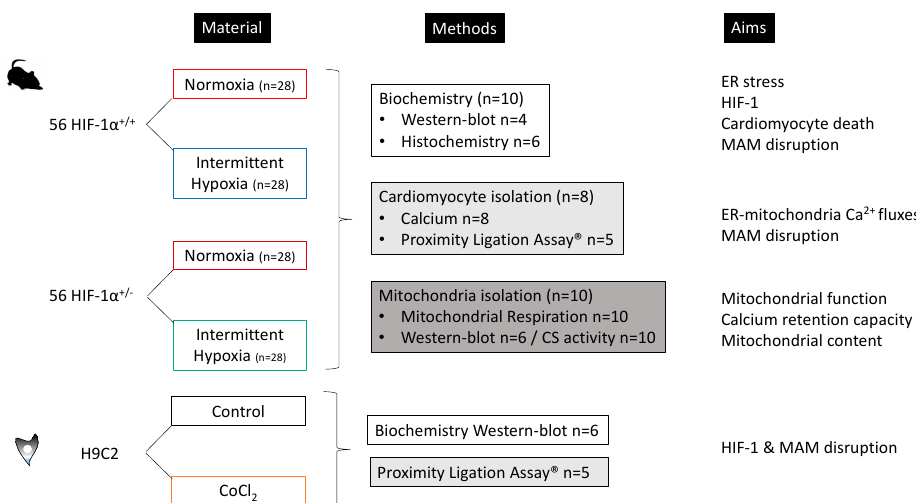
Figure 1. Experimental design: repartition of wild-type mice SwissxSV129 (HIF-1 α +/+ ) and HIF-1 α heterozygous mice (HIF-1 α +/ − ) in normoxia and intermittent hypoxia during 21 days before heart harvesting, in order to explore the impact of IH on endoplasmic reticulum (ER), ER-mitochondria Ca 2+ fluxes, mitochondria and mitochondria-associated ER membrane (MAM) homeostasis (bio- chemical analysis, cardiomyocyte isolation and mitochondria isolation); in vitro model using H9C2 cardiomyoblast treated, or not, with CoCl 2 (100 uM, 1 h), in order to validate the impact of HIF-1 activation on MAM integrity (Western blot and proximity ligation assay).